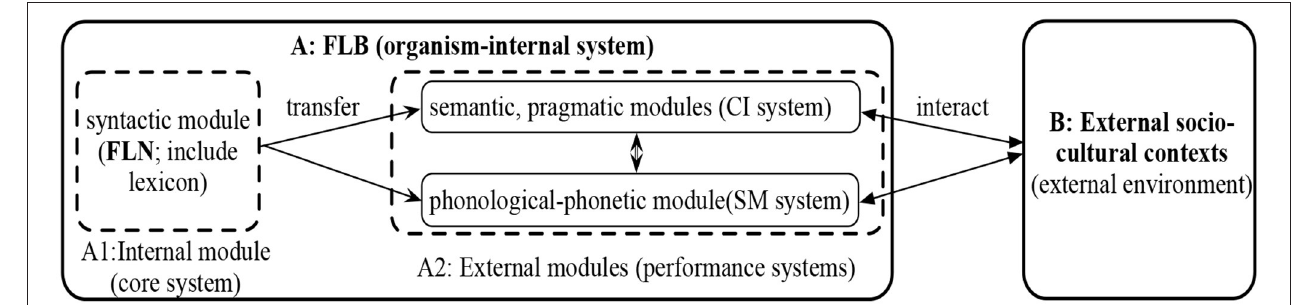
FIGURE 2 | Intreractions in FLB and sociocultural contexts (Mao,